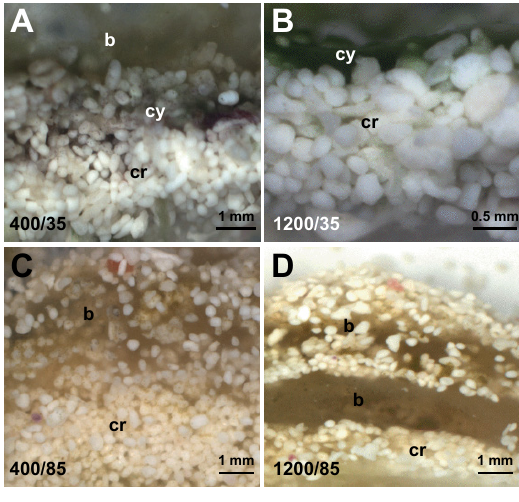
Figure 7. Morphological characterization of microbialites after six-month incubation. Each light-level micrograph depicts a cross section of the microbialites. (A) Microbialites incubated under ambient environmental conditions for the duration of the six month incubation retain the three primary layers: EPS-rich biofilm (b), cyanobacterial (cy) and fused ooid crust (cr); (B) Microbialites incubated under elevated CO levels have a pronounced cyanobacterial 2 (cy) layer overlaying a micritic crust (cr) layer; (C , D) Microbialites incubated under elevated salinity have no visible cyanobacterial layer and a pronounced caramel colored EPS-rich biofilm (b) layer overlaying a micritic crust (cr). The environmental parameters within each environmental treatment are listed in the lower left corner and include the CO 2 and salinity levels,